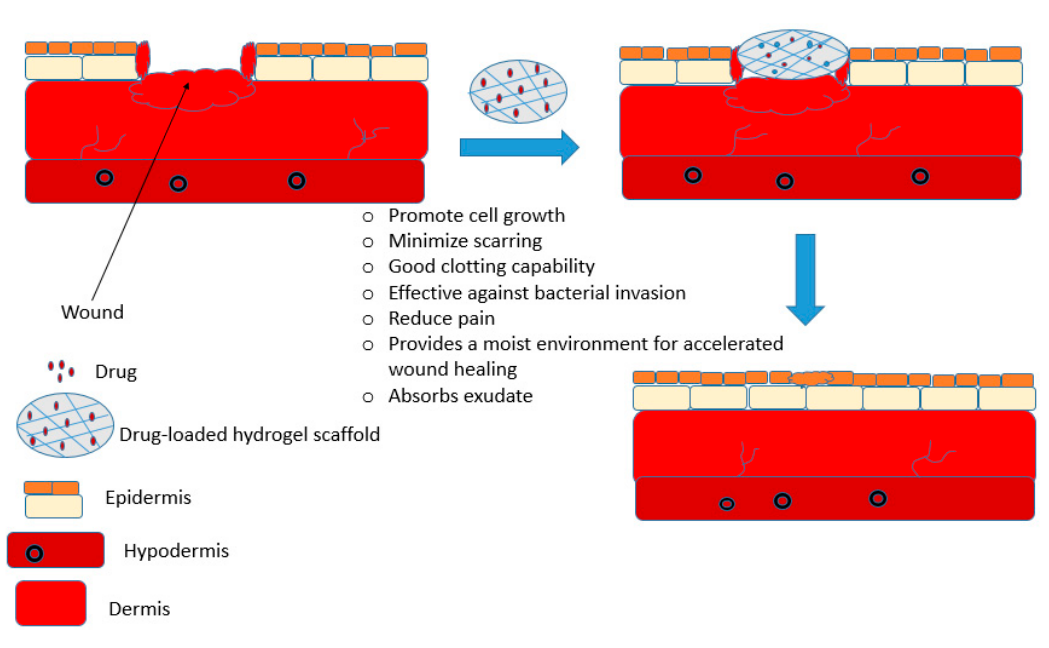
Figure 5. A schematic diagram illustrating the efficacy of chitosan-based hydrogel as an effective wound dressing.